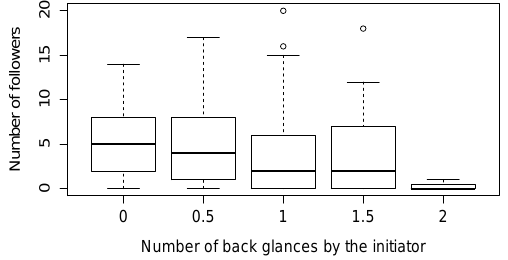
Figure 3. Effect of back glances on the number of followers. The number of followers significantly decreased with the rate of back glances by the initiator during the collective movements (GLMM, estimate =− 0.29, SE = 0.09, Z =− 3.25, N = 283, p = 0.001). For reasons of clearer representation we rounded the rate of back glances to 0.5 per minute. The figure shows medians (bold line), 25–75th percentiles (box), 5–95th percentiles (whiskers) and out- liers